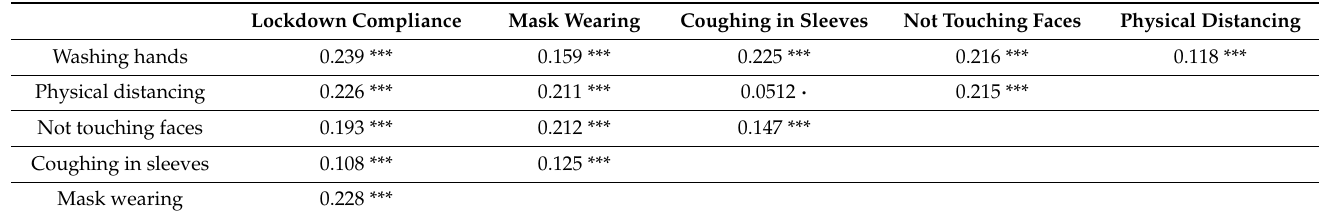
Table 4. Pairwise correlations between the prophylactic